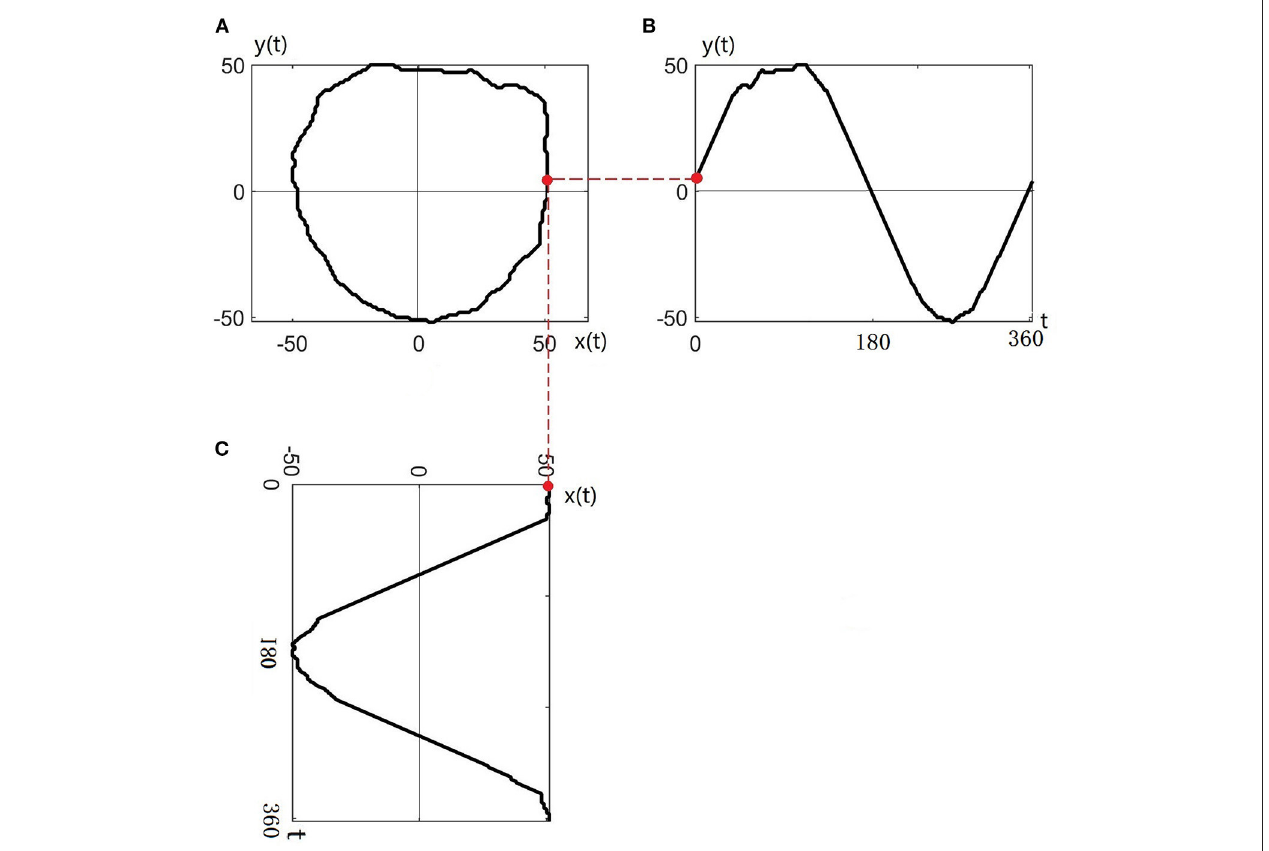
FIGURE 3 | Transferring the contour of the nerve bundle to the complex plane: (A) Original contour of the nerve bundle; (B) Contour profiled to the y ( t ) plane; (C) Contour profiled to the x ( t )